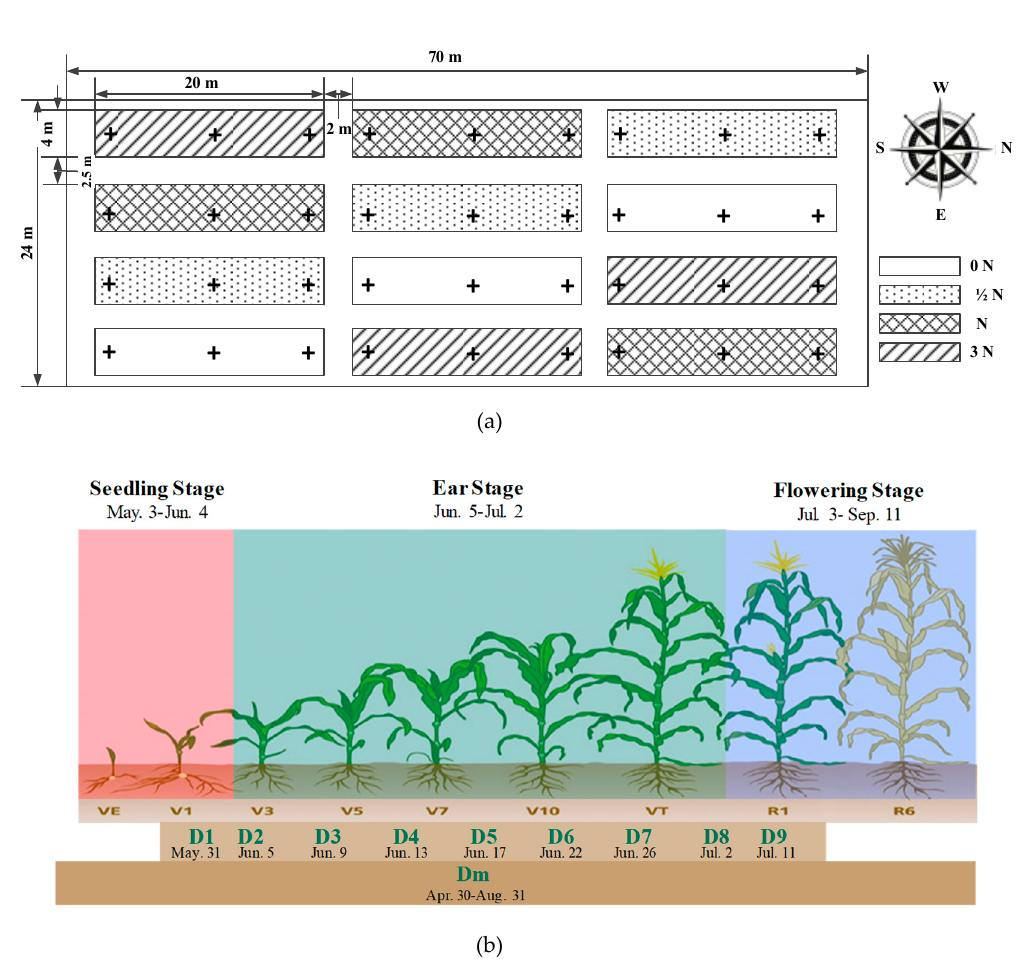
Figure 2. Soil Sampling Information: ( a ) Sampling space position inside the field ( b ) Sampling time.